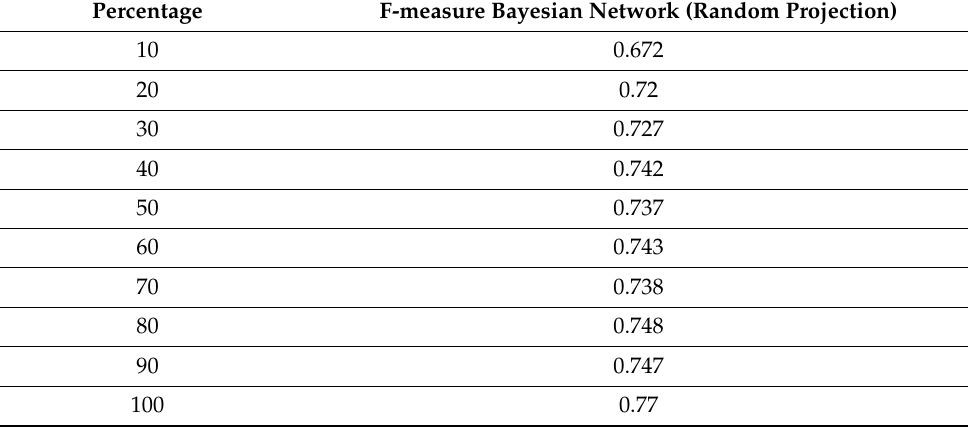
Table 5. F-measure for Bayesian Network with a random Table 5. F ‐ measure for Bayesian Network with a random projection.